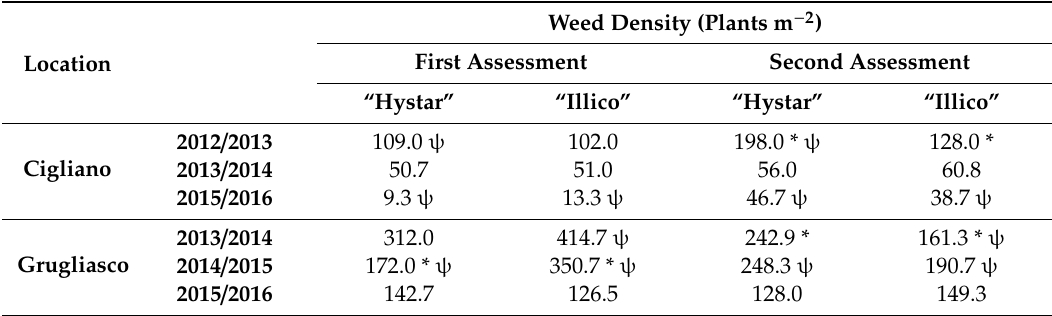
Table 4. Weed density measured at the two locations in the period 2012–2016 on WEEDED plots.